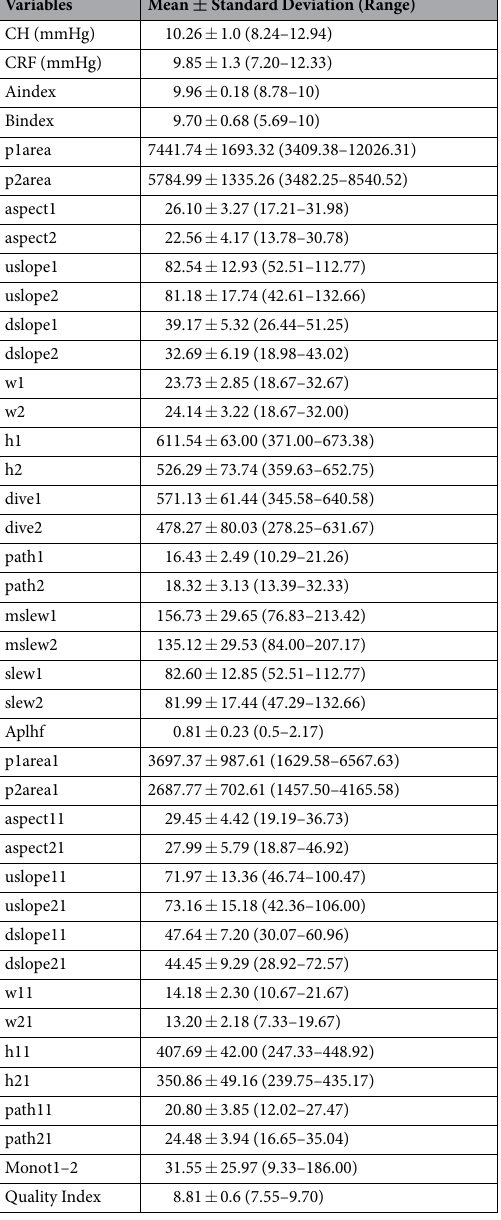
Table 2. Summary descriptive statistics of ORA parameters. ORA: Ocular Response Analyzer; CH: corneal hysteresis; CRF: corneal resistance